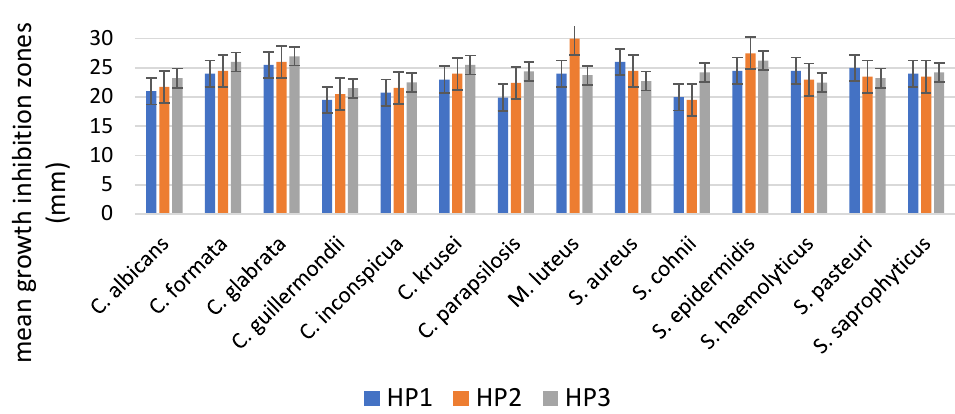
Figure 5. Mean growth inhibition zones (mm) caused by films containing three concentrations of propolis. The results are means of three replicates for the examined isolates of pathogenic Candida (n = 18) and commensal skin bacteria (n = 8). Error bars represent standard deviations.